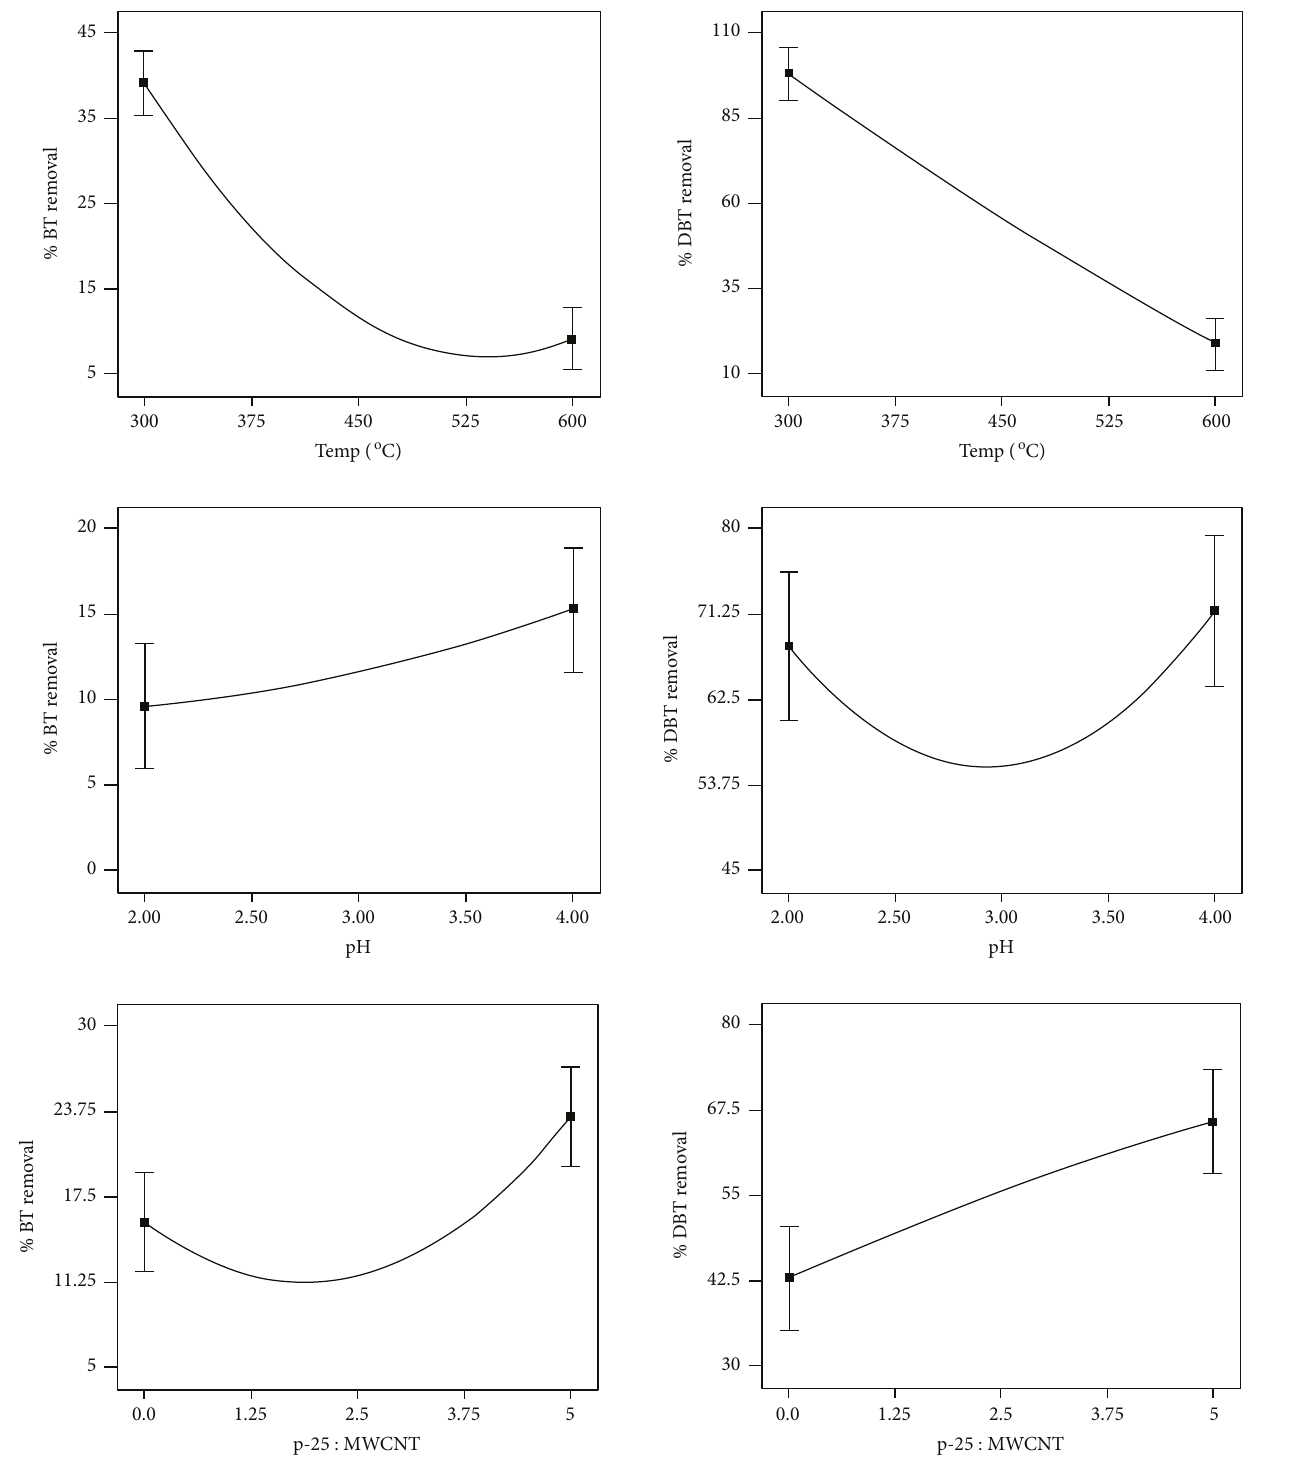
Figure 3: Main e ff ect plots for the photooxidation of BT and